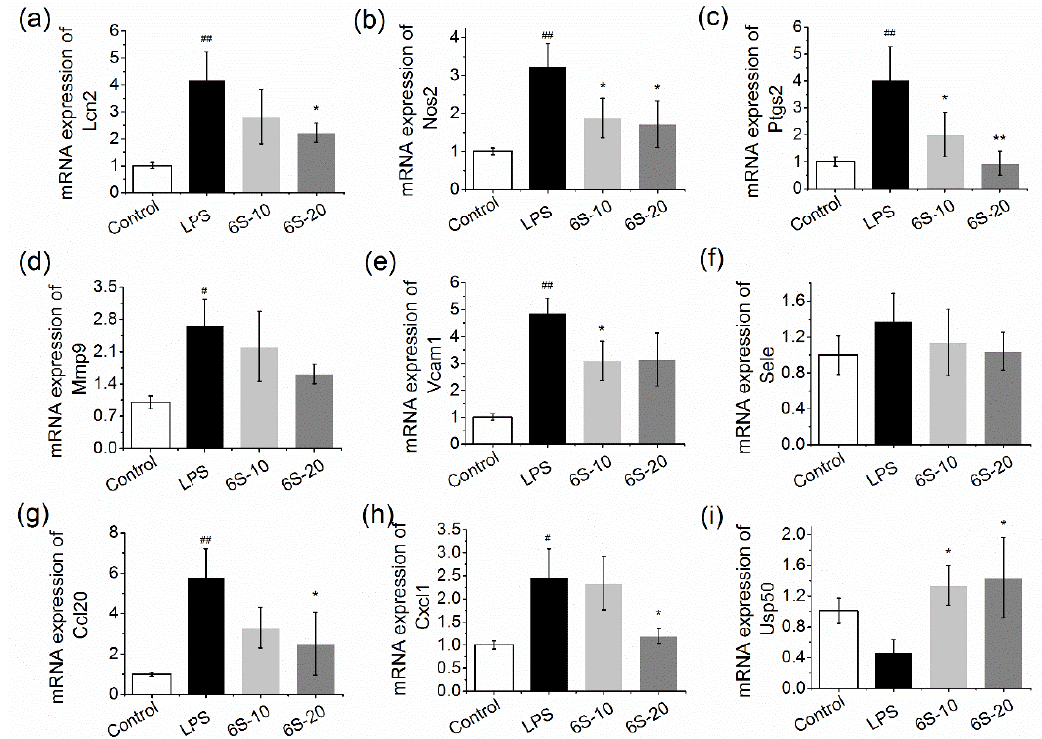
Figure 6. 6-Shogaol inhibited overlapped gene mRNA expression in LPS-treated BRL-3A cells. BRL-3A cells were pre- treated with 6- shogaol for 12 h before treated with LPS (0.1 μg/mL) for 5 h: ( a ) mRNA expression of Lcn2; ( b ) mRNA expression of Nos2; ( c ) mRNA expression of Ptgs2; ( d ) mRNA expression of Mmp9; ( e ) mRNA expression of Vcam1; ( f ) mRNA expression of Sele; ( g ) mRNA expression of Ccl20; ( h ) mRNA expression of Cxcl1; ( i ) mRNA expression of Usp50. 6S-10, 10 μM of 6-shogaol; 6S-20, 20 μM of 6-shogaol. Data are presented as mean ± SEM ( n = 6). # p < 0.05, ## p < 0.01 versus control group; * p < 0.05, ** p < 0.01 versus LPS group.